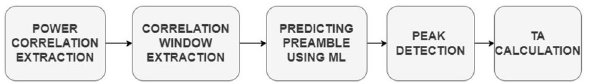
Figure 3. Machine learning preamble detection.